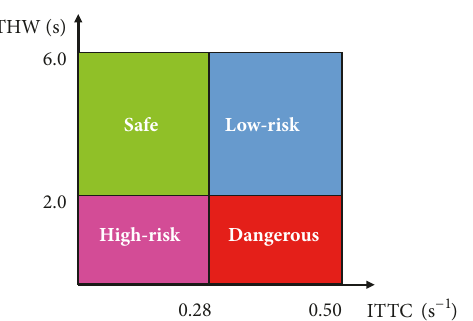
Figure 3: The threshold values of surrogates indicating different driving